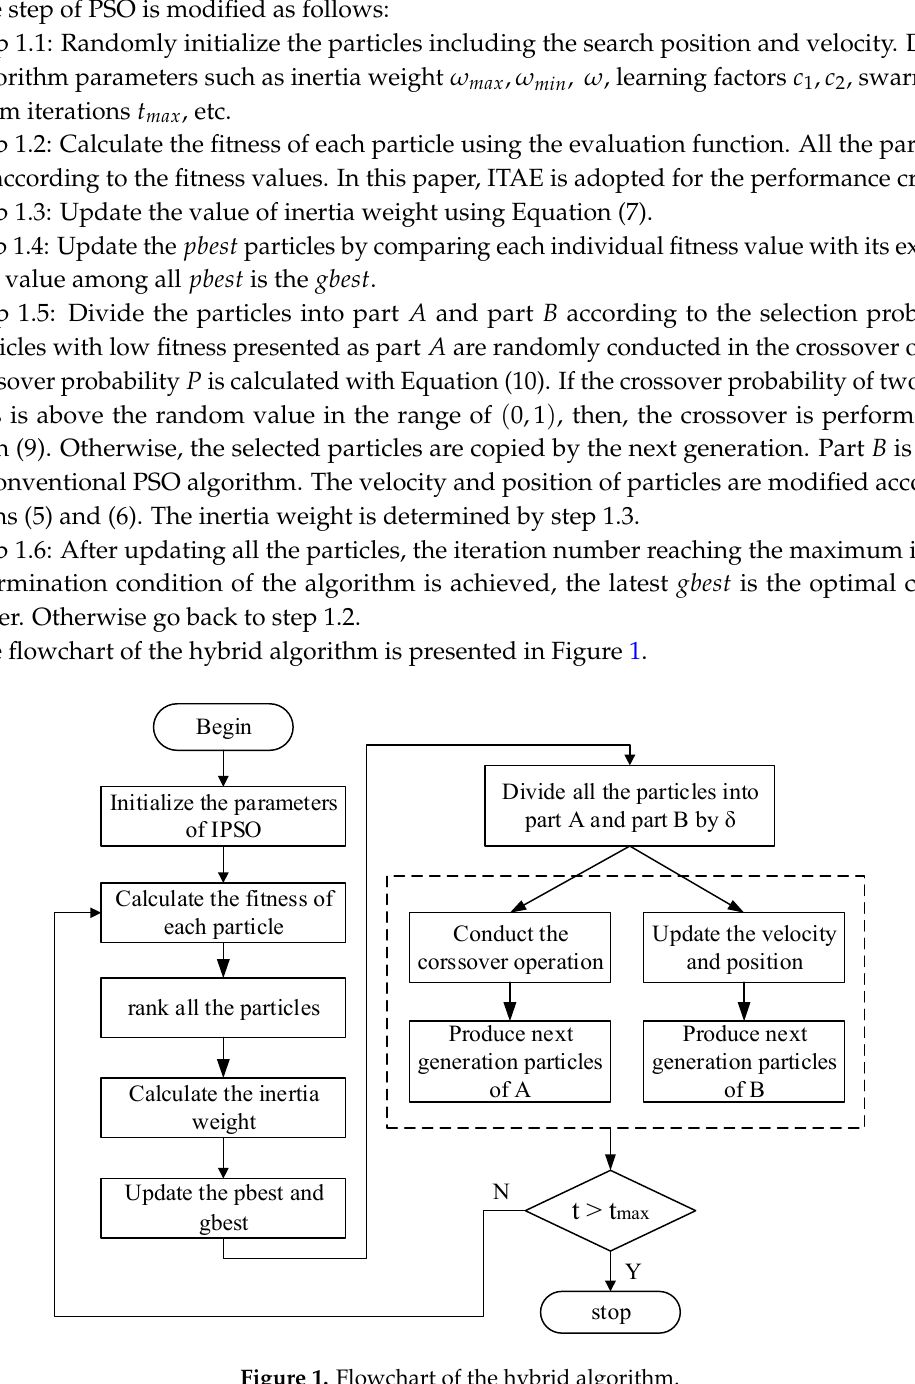
Figure 1. Flowchart of the hybrid algorithm.